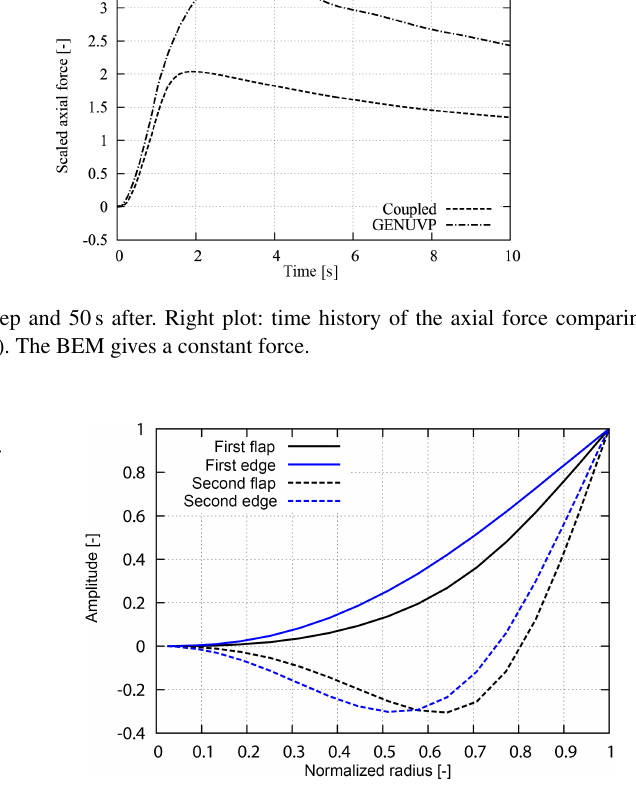
Figure 16. Mode shapes used in the work computations, which are simplified to be purely in-plane or out-of-plane deflections.